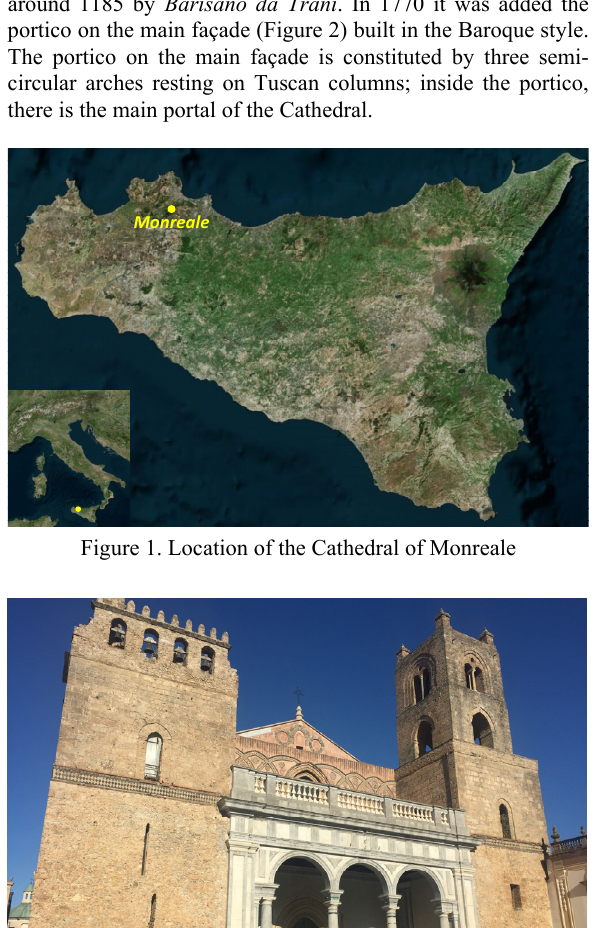
carved frame. The first arch, the inner, is decorated with